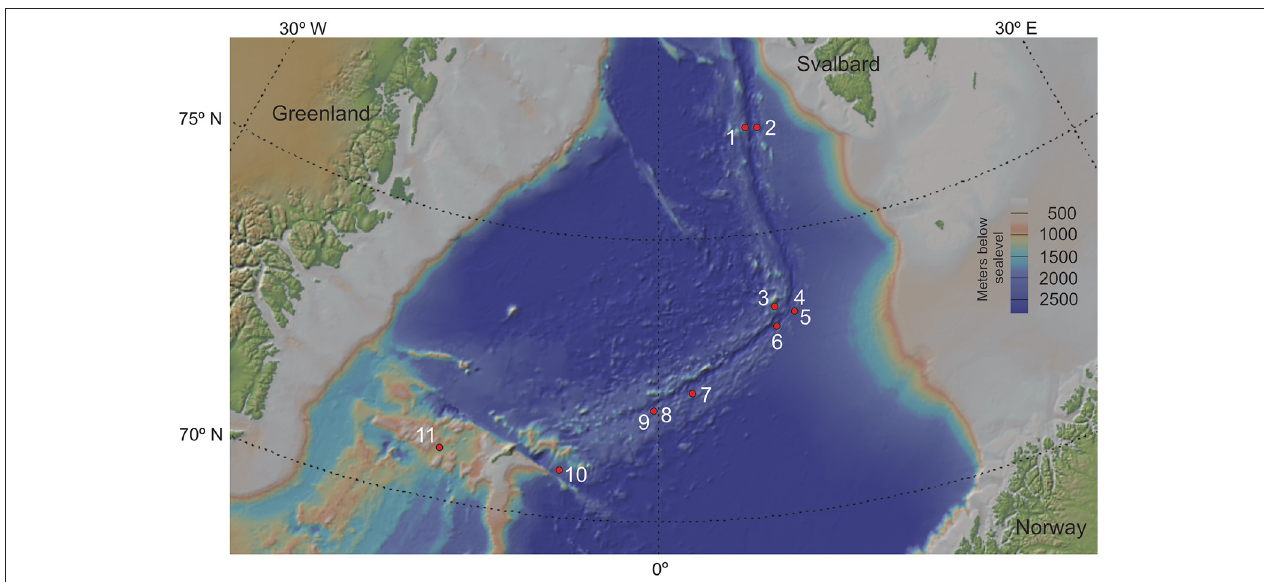
FIGURE 1 | Coring locations for all sediment cores used in this study. Cores labelled in red were discarded during post-processing and decontamination. GS14_GC08 and GS17_GC04, as well as GS15_GC01 and GS17_GC02 were retrieved too close for their points to be discernible on this map. The map was created using GeoMapApp (v.3.6.10; https://geomapapp.org). Coring location for all 11 sediment cores used in the analyses of this study. Numbers from 1-11 refers to core name; 1: GS16_GC05, 2: GS16_GC06, 3: GS14_GC09, 4: GS15_GC01, 5: GS17_GC02, 6: GS14_GC12, 7: GS16_GC04, 8: GS14_GC08, 9: GS17_GC04, 10: GS17_GC05, 11: GS14_GC02. Note that site 4 and 5 are from approximately same location, so are 8 and 9. The map was created using GeoMapApp (v.3.6.10;